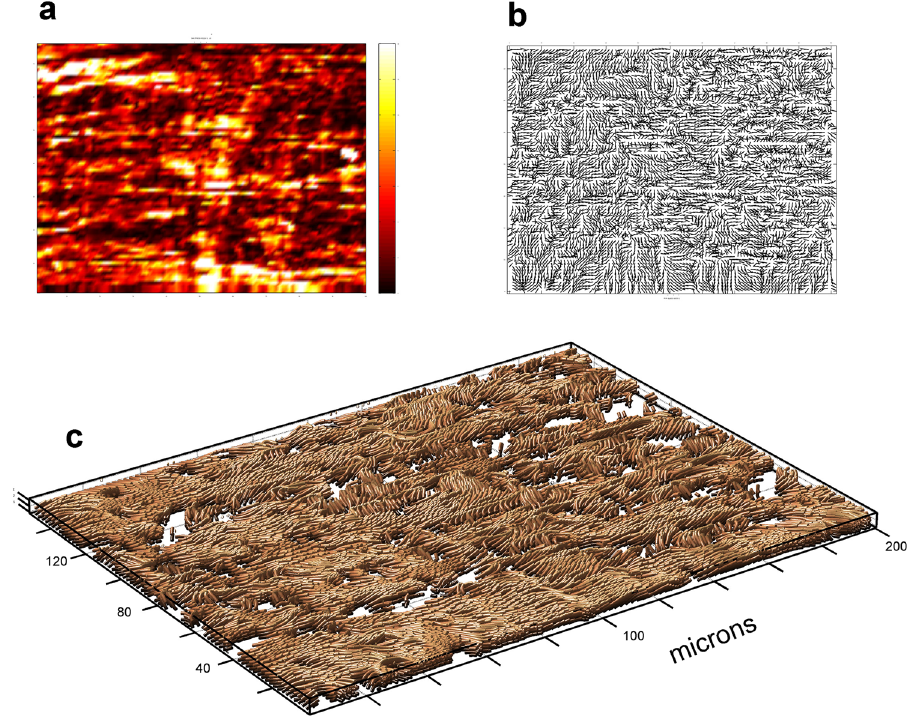
Figure 6. Comparison of 2-D SHG images with SHARP image of bovine deep fascia: ( a ) 2-D SHG intensity image of fascia reveals pattern of transverse fibrillar bundles, interspersed with shorter bundles with varying orientations; ( b ) 2-D in-plane orientation map suggests fibrillar interweaving, but this pattern may also be associated with disorder; ( c ) SHARP image illustrates the relationships among the bundles more